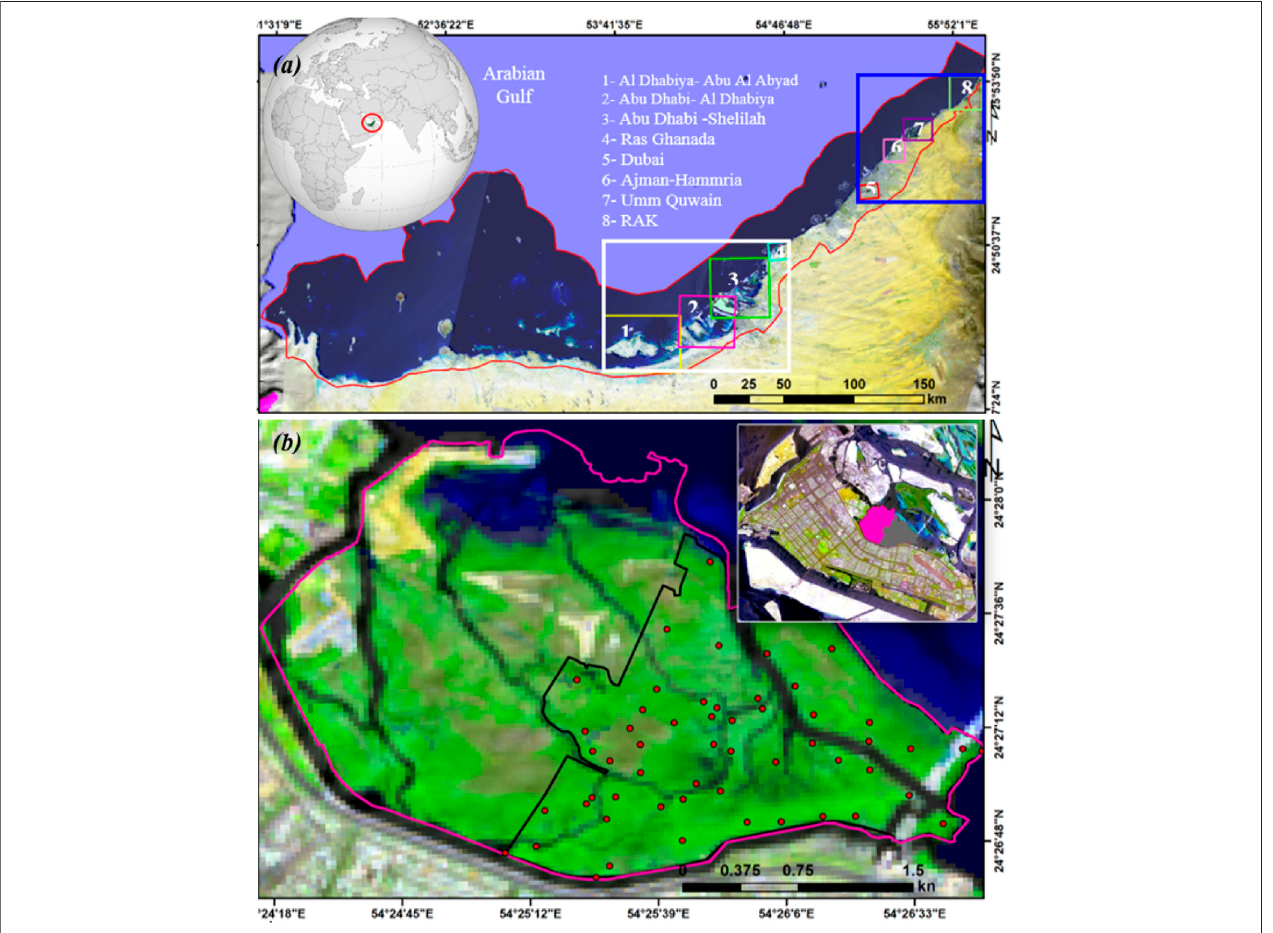
FIGURE 1 | RGB 541 band combination of Landsat image of the UAE showing the spatial distribution of the UAE mangroves along the western coast of the UAE. BlueandwhitesquareshighlightNUAEandAbuDhabimangrovelocations,respectively (A) ,andAbuDhabiNationalPark(pinkpolygon).Redpointshighlightthespatial distribution of soil sample and validation locations (B)